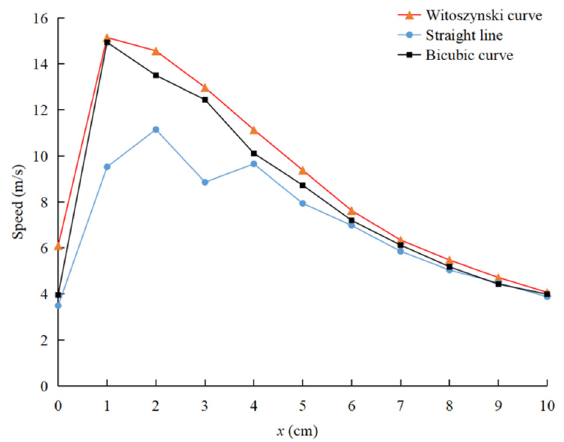
Figure 12. Velocity diagram of nozzles with three shrinkage curves at axis position.